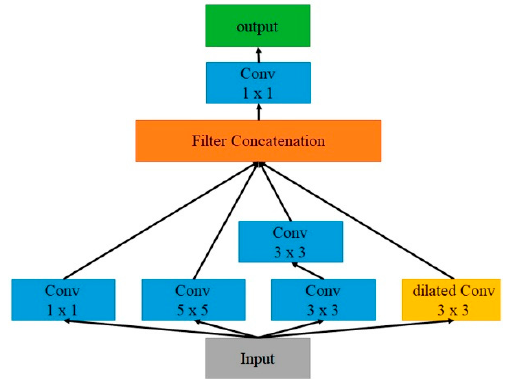
Figure 3. Dilated Inception block.